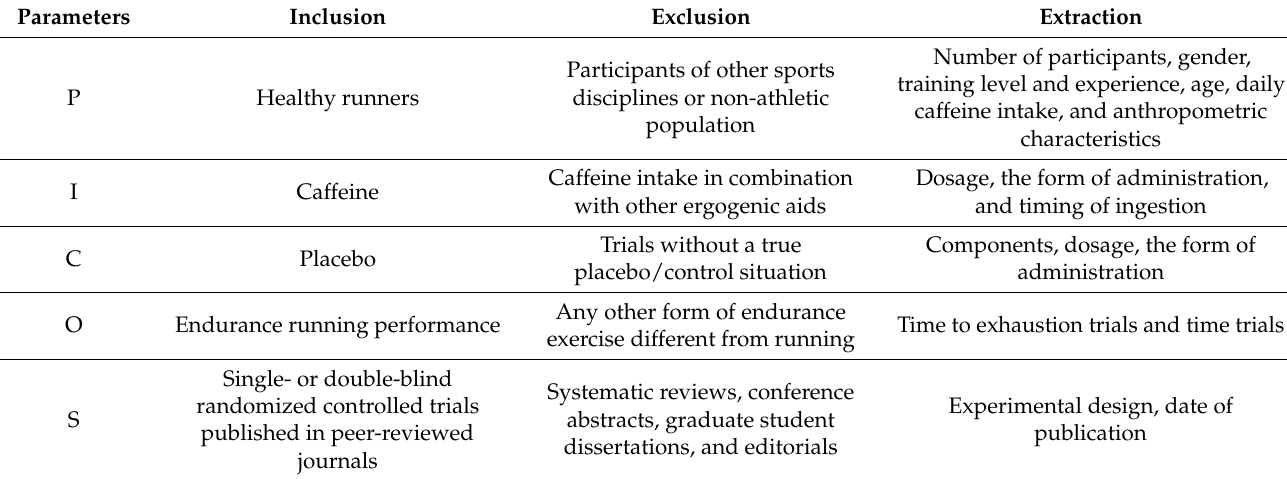
Table 1. PICOS criteria for the inclusion of crossover experimental designs in which the ingestion of caffeine was compared to a placebo in a single- or double-blind randomized manner. For inclusion, the study outcomes should be associated with endurance running